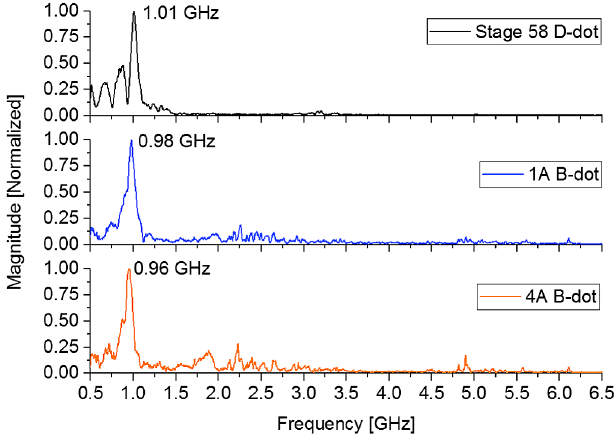
FIG. 8. High-pass filtered (500 MHz cutoff) voltage and current traces from Shot 20 of the 25 kV series (unfiltered waveforms shown in Fig. 6).